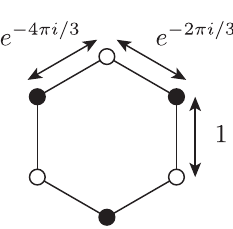
FIG. 4. Values of μ for different hopping directions from j to i ij